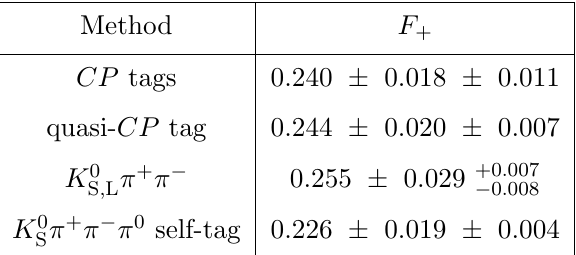
Table 5 . F + results from di(cid:11)erent